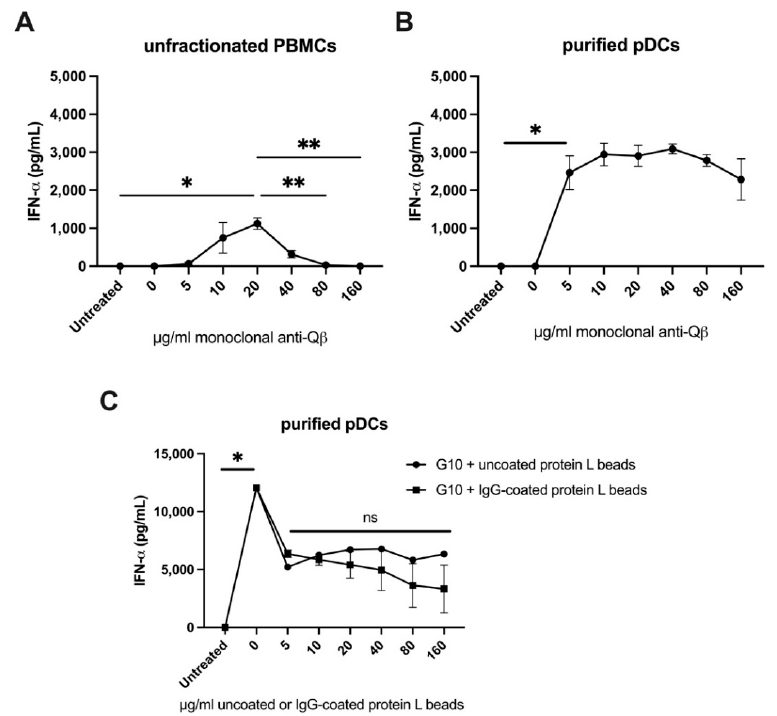
Figure 6. High concentrations of immune complexes do not inhibit Type 1 Interferon production by purified pDCs. Unfractionated PBMCs ( A ) or purified pDCs ( B ) from the same PBMC donor were treated with vidutolimod and various concentrations of anti-Q β antibody and supernatant was tested for IFN α by ELISA ( n = 3–4). Purified pDCs ( C ) were treated with G10, a soluble TLR9 agonist and various concentrations of uncoated or IgG-coated protein L beads and supernatant were tested for IFN α by ELISA ( n = 1–2). Graphs depict means +/ − SEM. Statistical significance was determined using multiple paired T test with alpha = 0.05 (ns = not significant; * p < 0.05; ** p < 0.01). No significant differences were noted in IFN α levels between 5 and 160 μ g/mL of IgG-coated protein L beads. Immune complex interactions with monocytes are responsible for reduced Type 1 Interferon production in response to vidutolimod. To assess the role of monocytes in the PBMC response to vidutolimod plus high concentrations of anti-Q β , purified pDCs and monocytes were cocultured and treated with vidutolimod and various concentrations of anti-Q β antibodies (Figure 7A). In parallel, pDCs and monocytes were cocultured with G10 to provide TLR9 stimulation and various concentrations of IgG+ protein L beads to serve as immune complexes (Figure 7B). Immune complexes in both conditions resulted in reduced Type I Interferon production in response to TLR9 stimulation.